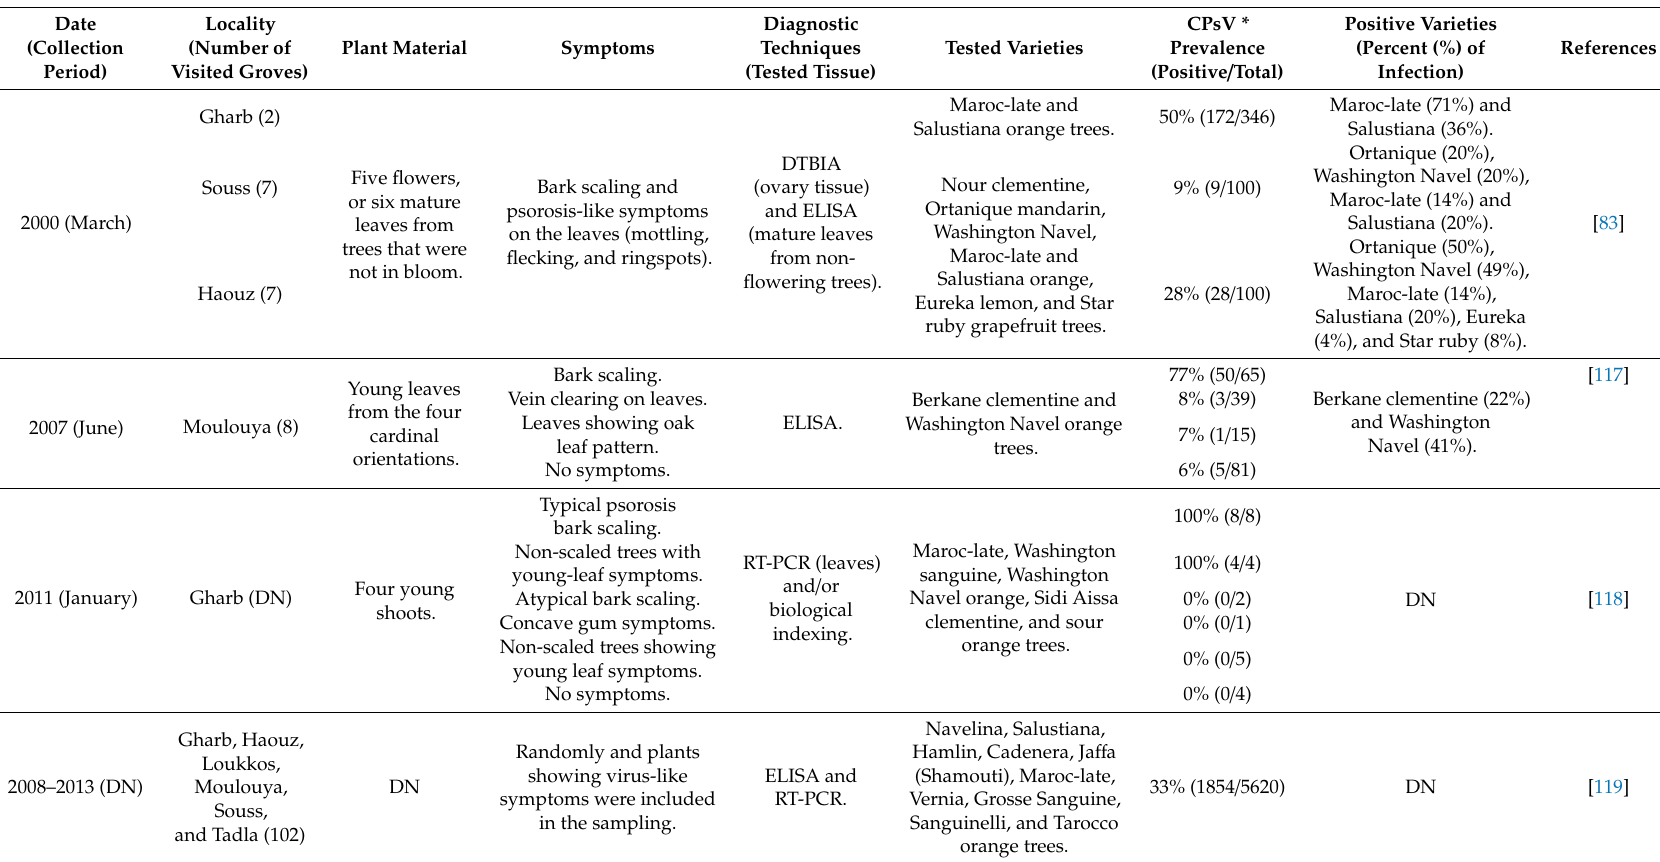
Table 3. Results summary of the known field surveys carried out in the main citrus-growing areas of Morocco to monitor CPsV